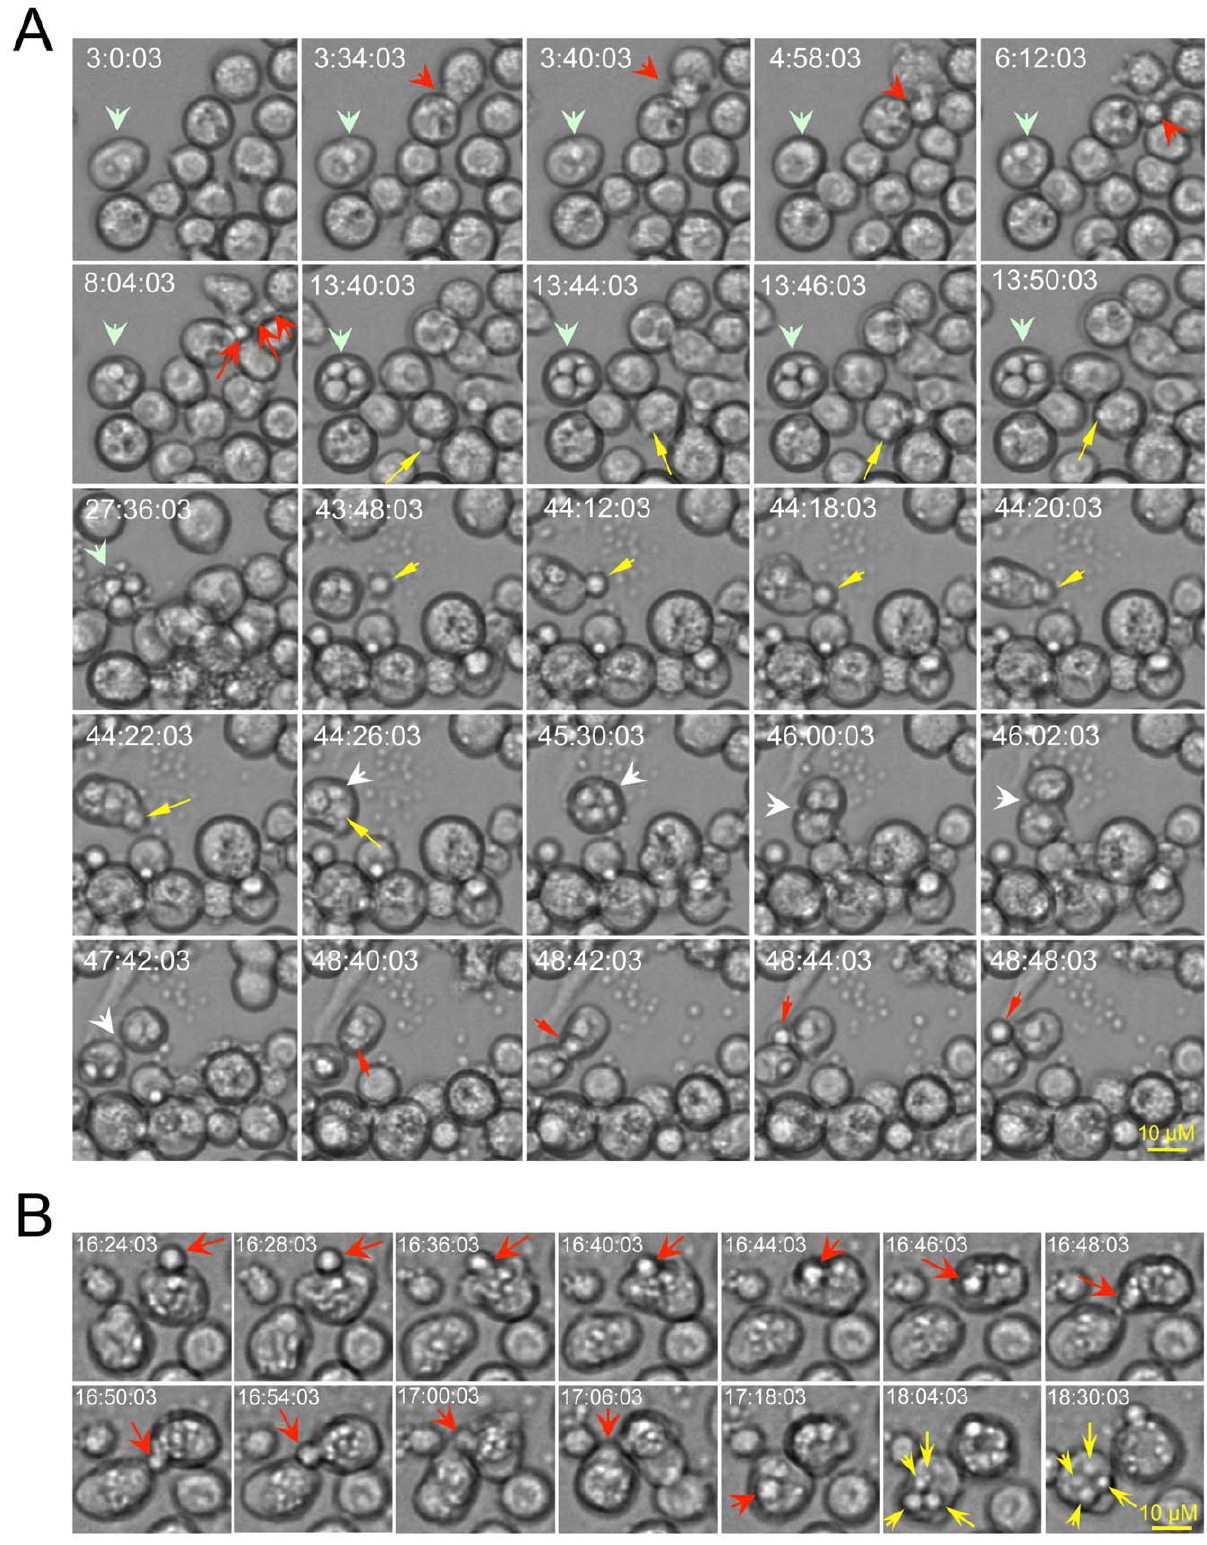
Figure 1. Live cell images indicate that Drosophila S2 cells support the phagocytosis, intracellular replication, cell-to-cell dissemination and escape of Cryptococcusneoformans (Cn). Live cell images were selected from a representative time-lapse movie (n=3). Time-lapse images were taken every 2 min. Frames are labeled according to the start of the imaging process, which was initiated approximately 3.5 hrs post-infection. Before the imaging was initiated, the infected cells were washed three times with 1 6 PBS. Fresh serum-free medium supplemented with 20 m g/ml fluconazole was then added to the cells to inhibit the replication of the extracellular (but not intracellular) population of Cn cells. A . Drosophila